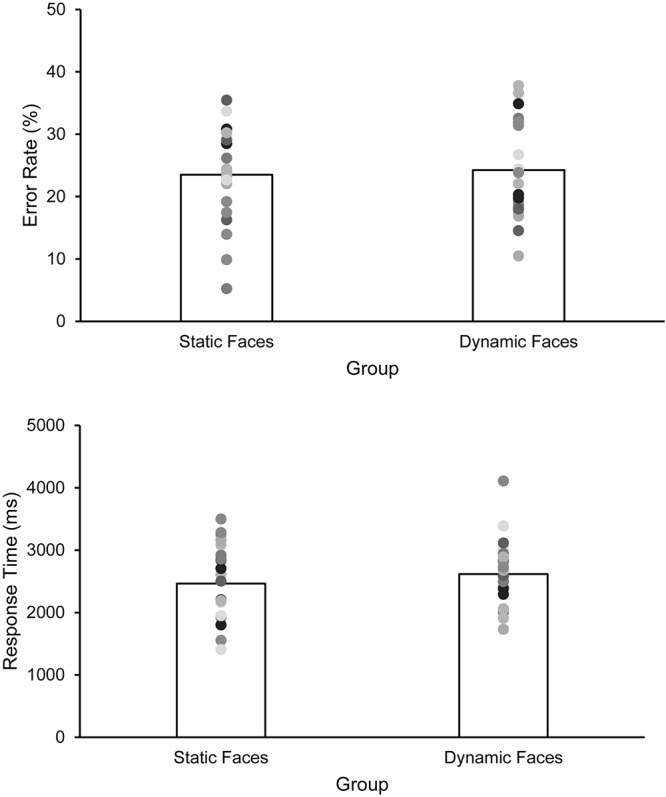
Matching performance (upper panel, error rates in %) and RTs (lower panel, in ms) as a function of group (static vs. dynamic faces). Bars indicate the arithmetic means, dots represent individual data points. Note, however, that instructions did not emphasize response speed in the first place.